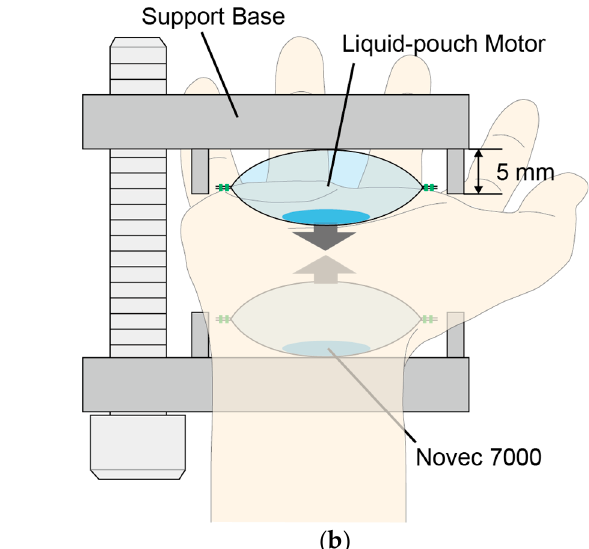
Figure 2. Photograph of proposed haptic glove: ( a ) palm side and ( b ) back side of the hand.